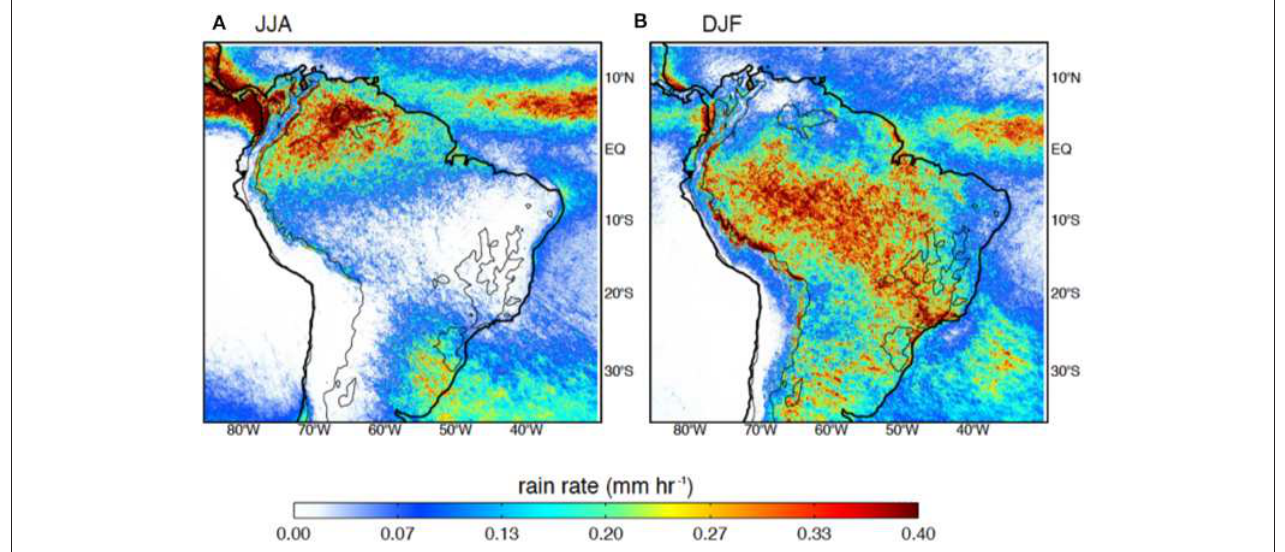
FIGURE 4 | Average rain rate from TRMM distinguishable rain areas during the months of (A) JJA and (B) DJF from 1998 to 2013. The black thin contour characterizes the 700m elevation. Adapted from Houze et al.